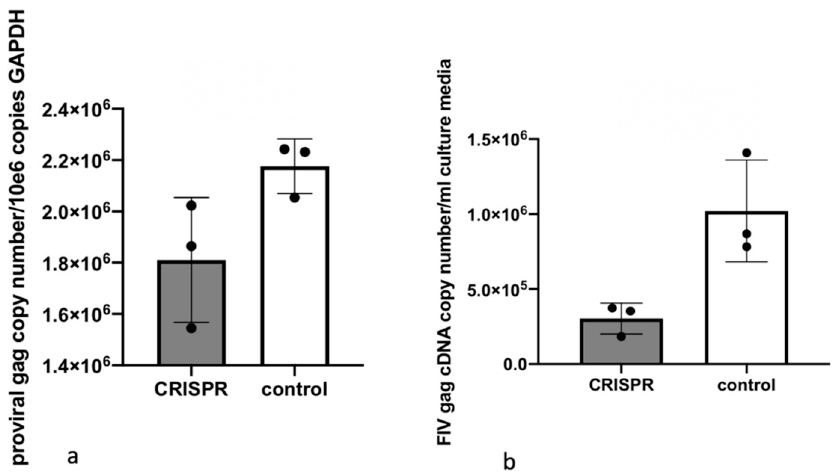
Figure 7. Experiment 1. ( a ) In chronically FIV-infected MCH5-4 cells (infected for 20 days with FIV followed by 7 days of infection with FIV CRISPR Cas9), cells treated with the CRISPR gene editing tool (grey bars) have a reduction in the mean proviral DNA relative to untreated control cells (white bars). ( b ) Cell-free FIV is reduced in culture media derived from cells treated with the CRISPR reagent relative to untreated control cells. The bar represents the mean while the error bars represent the standard deviation of three parallel experiments.